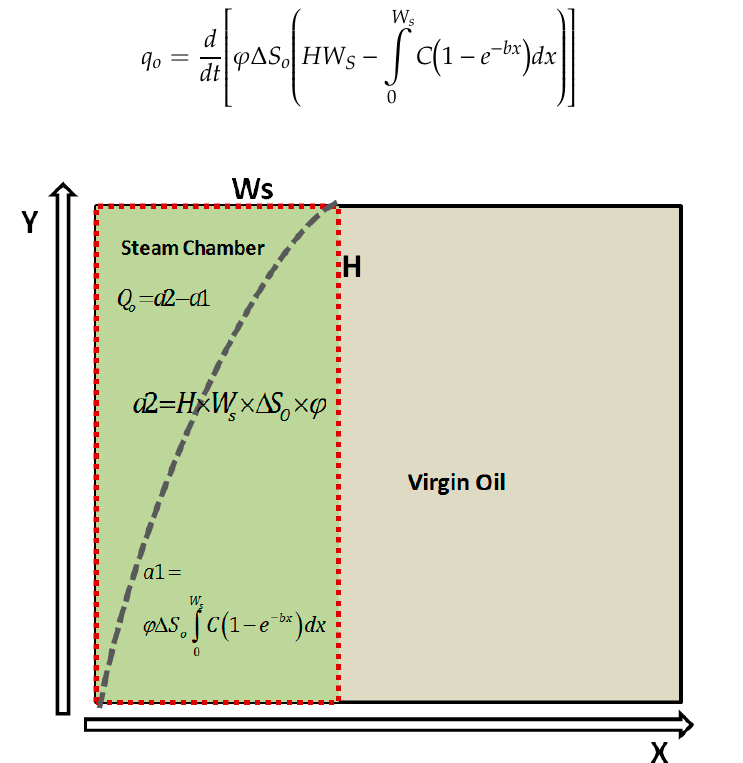
Figure 3. A cross section area inside the reservoir during the SAGD operation. The figure shows a1 as the area below the interface and a2 as the area below Ws .